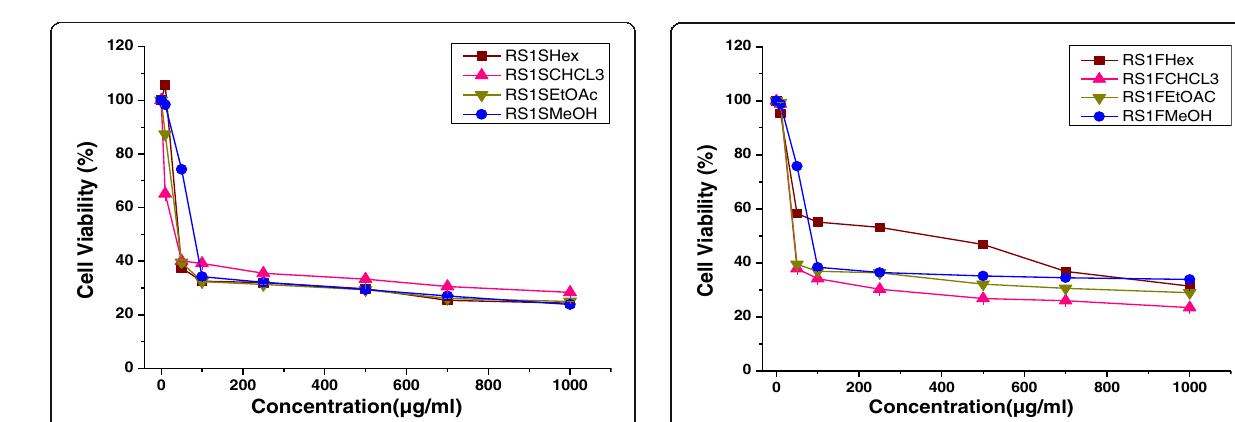
Fig. 3 Growth inhibitory activity of solvent extracts of Rhazya stricta stems on NT2 cells. The cells were incubated with different concentrations for 48 h, and the cell viability was determined by the MTS assay. The percent inhibition was calculated in comparison to the vehicle control (0.01% MeOH) of two independent experiments. Abbreviations: Hexane extract of Rhazya stricta stems (RS1S Hex), chloroform extract of Rhazya stricta stems (RS1S CHCL3), ethyl acetate of Rhazya stricta stems (RS1S EtOAc), and methanol extract of Rhazya stricta stems (RS1S MeOH)